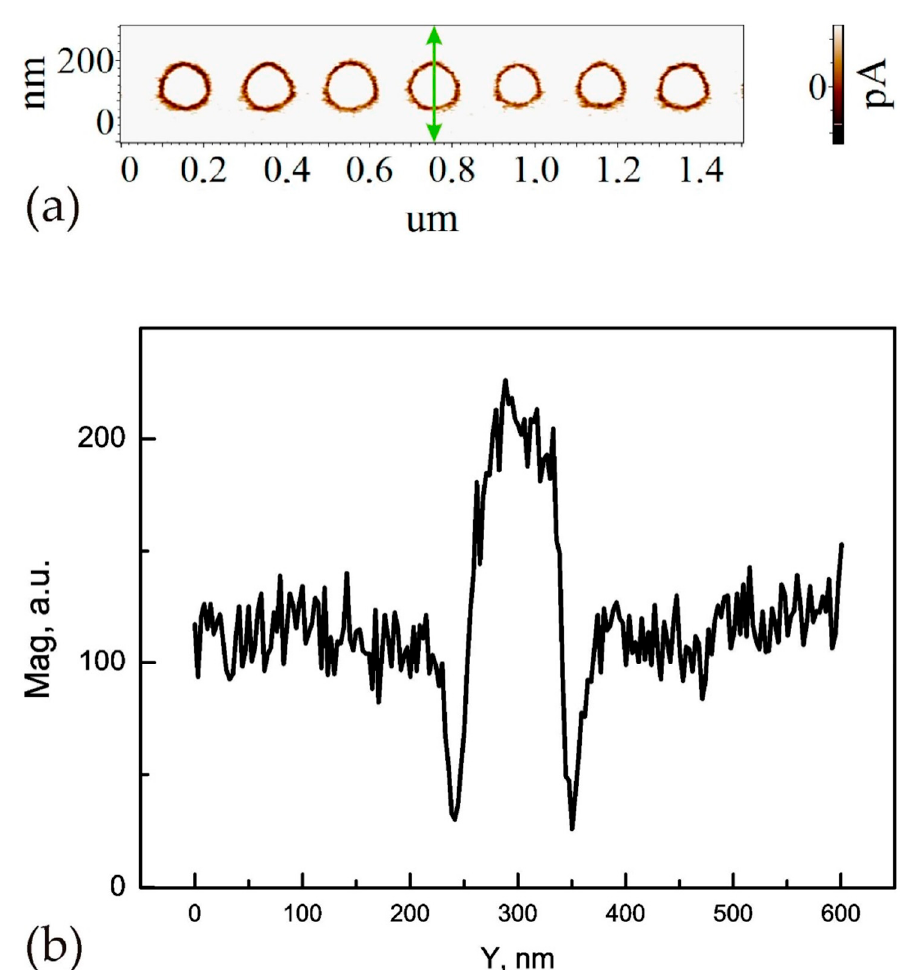
Figure 3. The amplitude PFM image of an AFM-written domain chain underlying the below calculations of DWC ( a ) and the scanline of an individual domain (marked with a green arrow in PFM image) composing this chain ( b ); Utip = 27 V, tp = 500 ms; the AFM-tip radius r ≤ 10 nm.